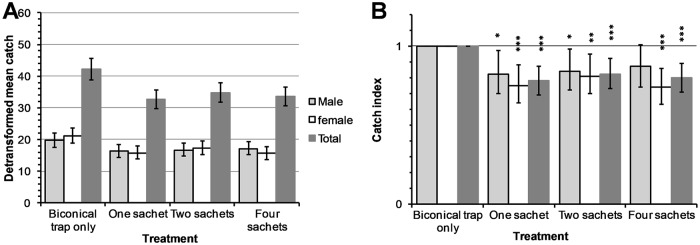
4-methylguiacol dispensed from varying number of sachets at biconical traps.Detransformed means (A) and indices (B) of G. f. fuscipes catches. Error bars indicate 95% CI of the detransformed mean (A) and indices (B) of tsetse fly catches. *P<0.05, **P<0.01 and ***P<0.001.